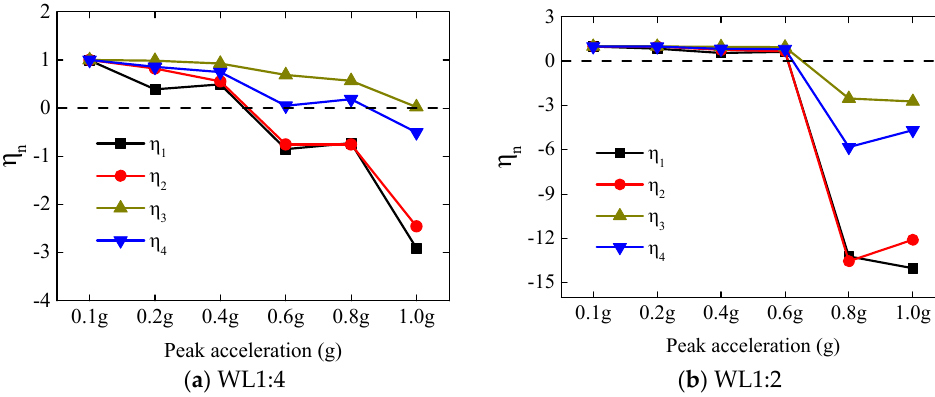
Figure 10. Ausilio [31] method under the WL wave with the η n value. Figures 11 and 12 show that the value of η n decreases with the increase of input peak acceleration, and the change amplitude is larger and larger. Under the condition of similarity ratio 1: 4 and similarity ratio 1: 2, the change trend of η n value is consistent. With the increase of peak acceleration, the trend line of η 1 value and η 2 value is gradually away from η 3 and η 4 . At 1.0 g, η 1 and η 2 are farthest from η 3 and η 4 . In the case of similarity ratio 1: 4, when the input peak acceleration is 0.1–0.6 g, the η 1 value is less than 0 under 0.2 g in Figure 11, and the other values are greater than 0, which shows that each calculation method is conservative in predicting the displacement value under small earthquakes,